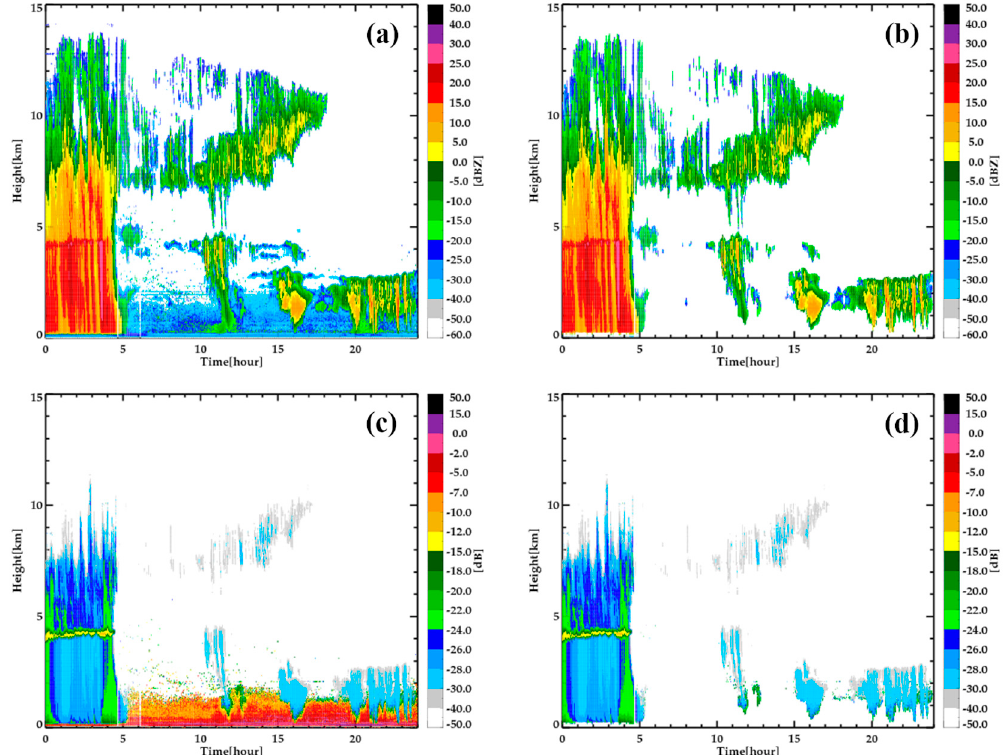
Figure 3. An example of ( a , b ) reflectivity and ( c , d ) linear depolarization ratio (LDR) before (left panel) and after (right panel) applying the quality control procedure.